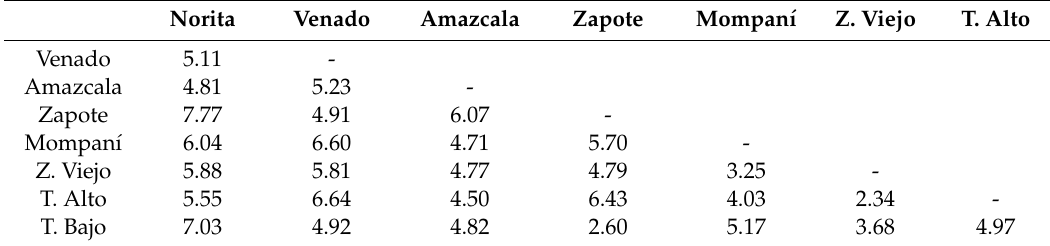
Table 5. Matrix of Euclidean distances among studied